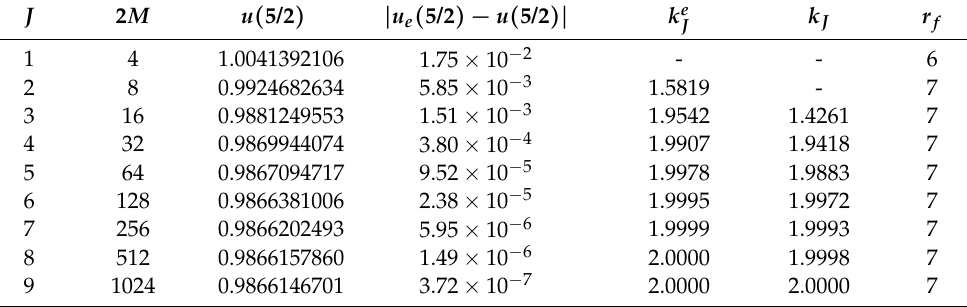
Table 1. Solutions to (17) where u e ( 5/2 ) = 0.986614298151 using HWM.